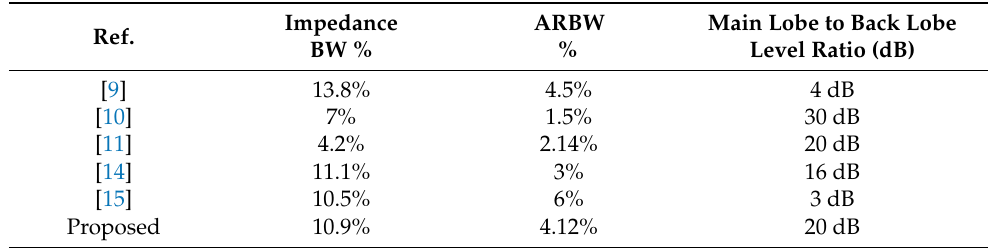
Table 1. Comparison between the proposed design with some important designs related to some other important designs.